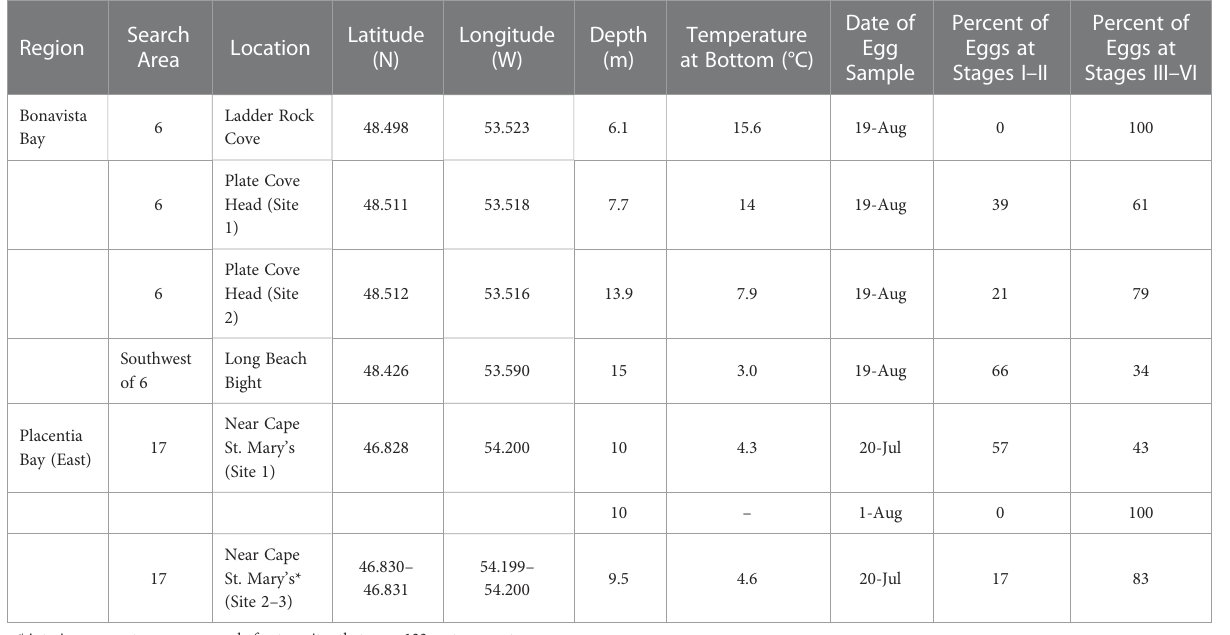
TABLE 2 Capelin eggs sampled at six of the seven newly found deep-water spawning sites in Placentia Bay and Bonavista Bay during July – August, 2019.